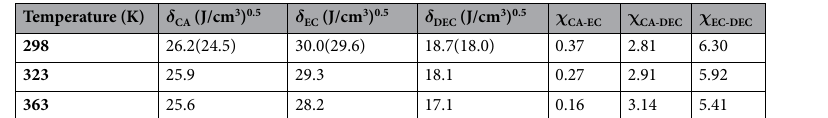
Table 1. Hildebrand solubility parameters ( δ s) and Flory-Huggins interaction parameters ( χ ij ’ s). The values in parentheses are from Hansen 37 and the average error percent is about ~4.2%.